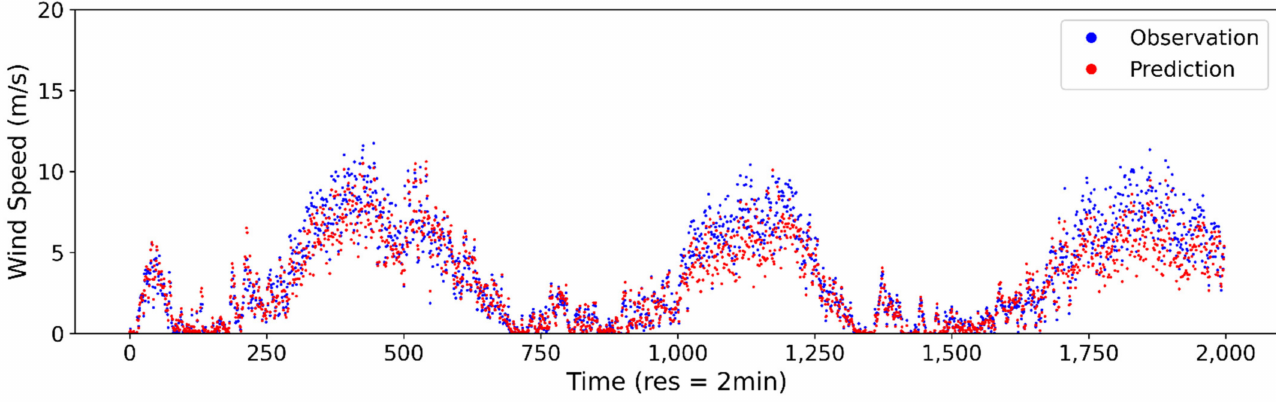
Figure A3. Estimated vs. observed wind speed at 2-min sampling interval using ANN model.